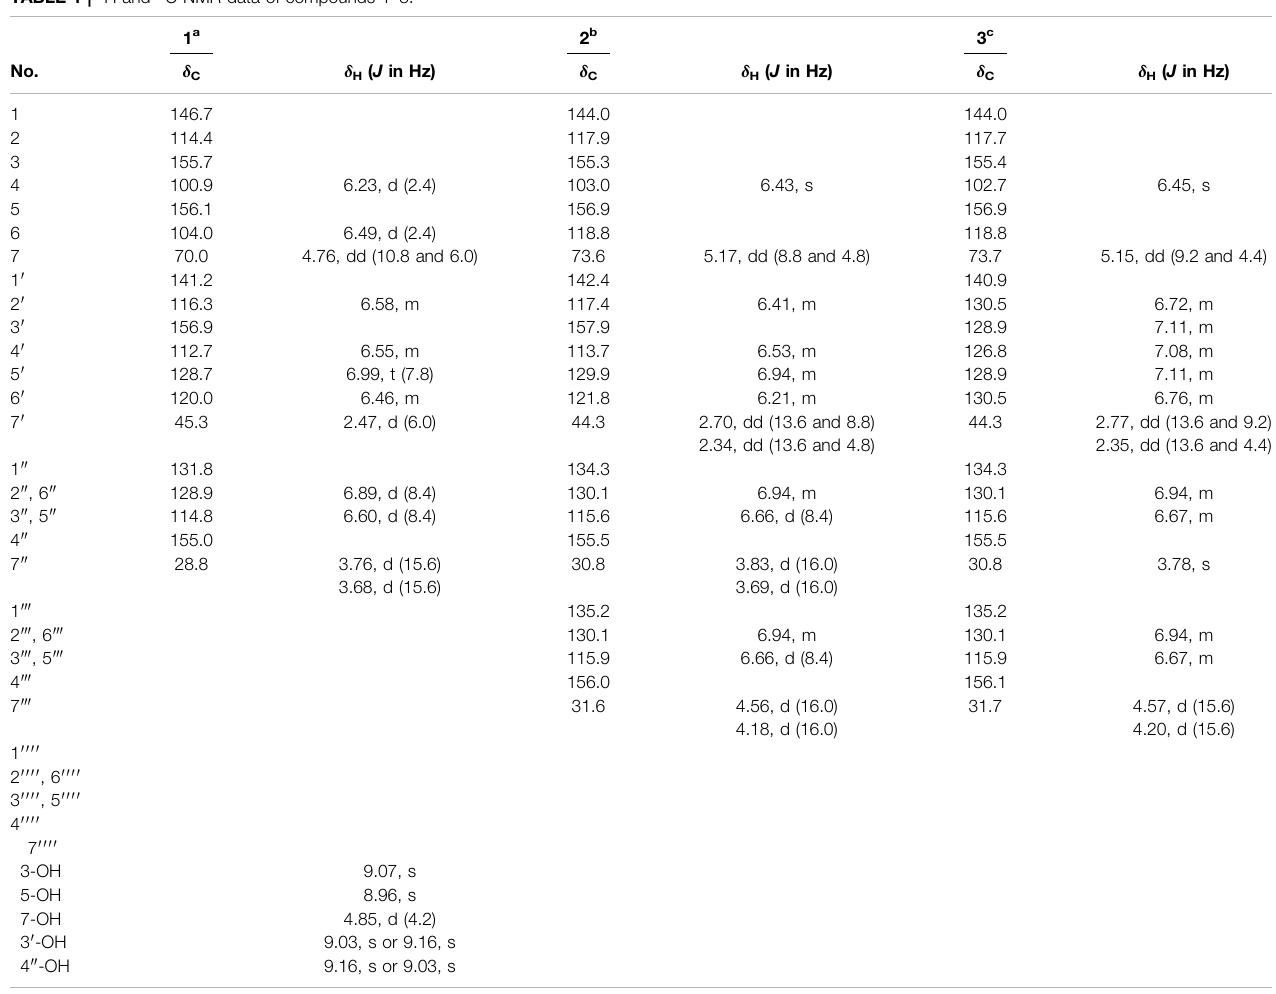
TABLE 1 | 1 H and 13 C NMR data of compounds 1 –